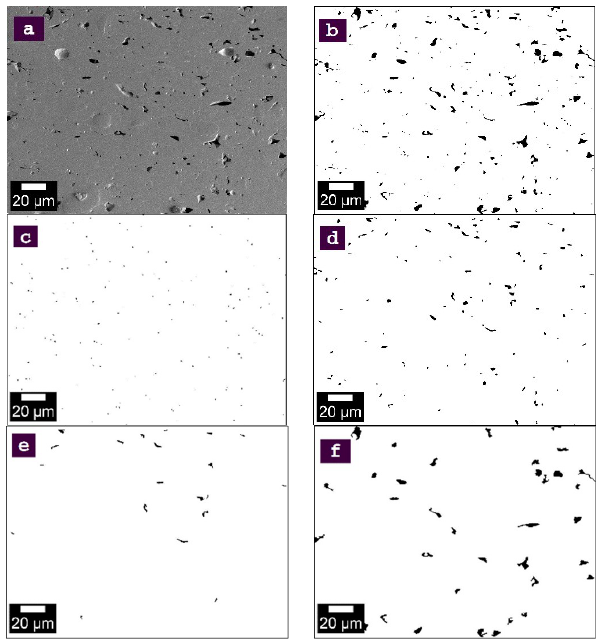
Figure 3. Pore classification process: ( a ) SEM gray image, ( b ) total porosity (binary image), ( c ) fine pores, ( d ) medium pores, ( e ) medium pores with a circularity <0.5, and ( f ) large pores.